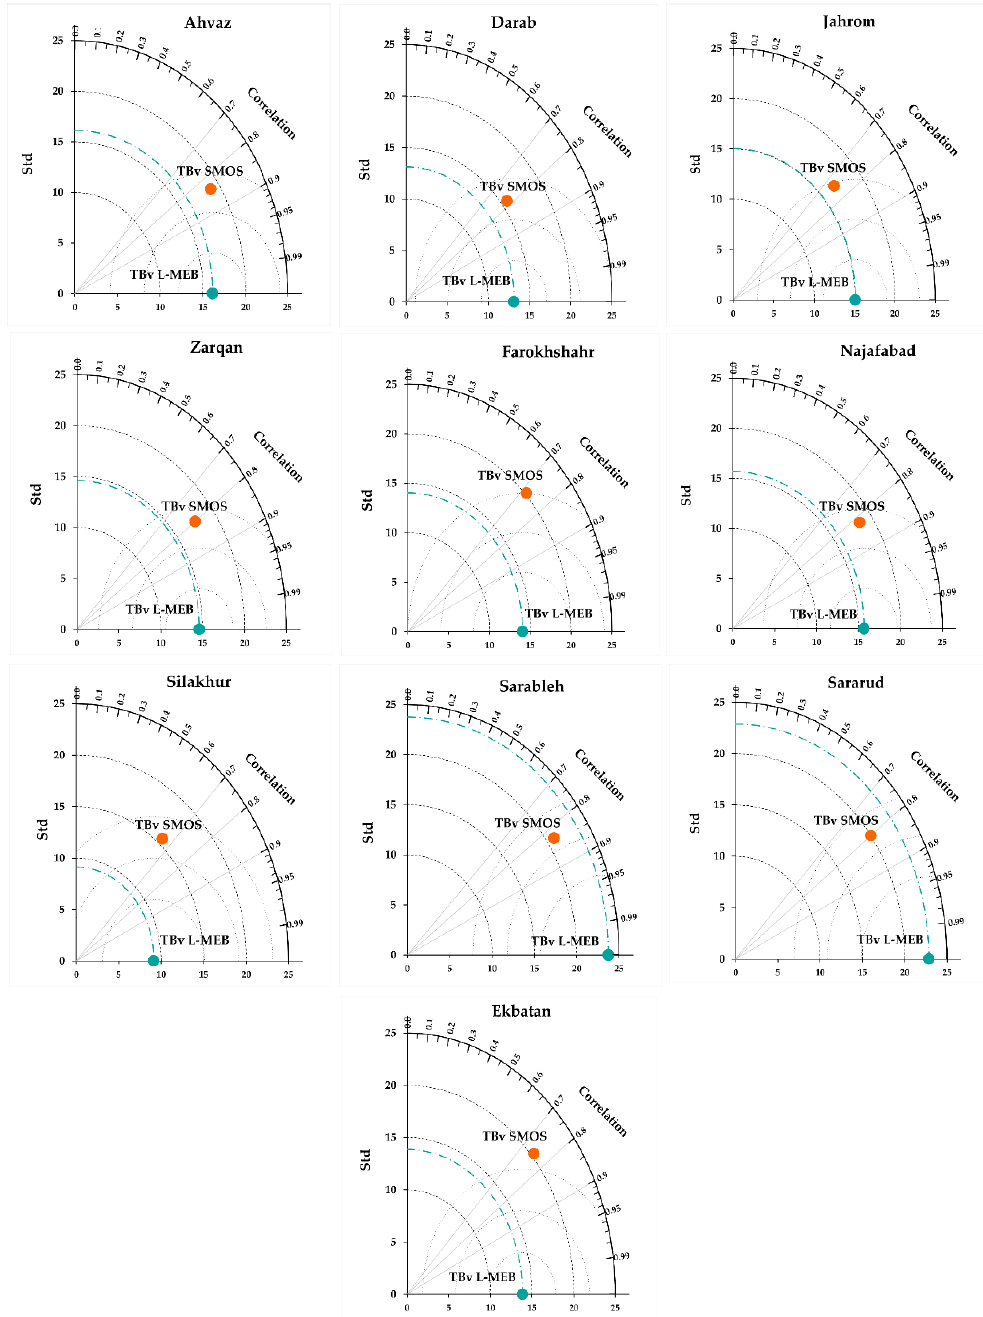
Figure 6. Taylor diagrams illustrating the statistics of the comparisons between TB V SMOS and TB V L-MEB data.